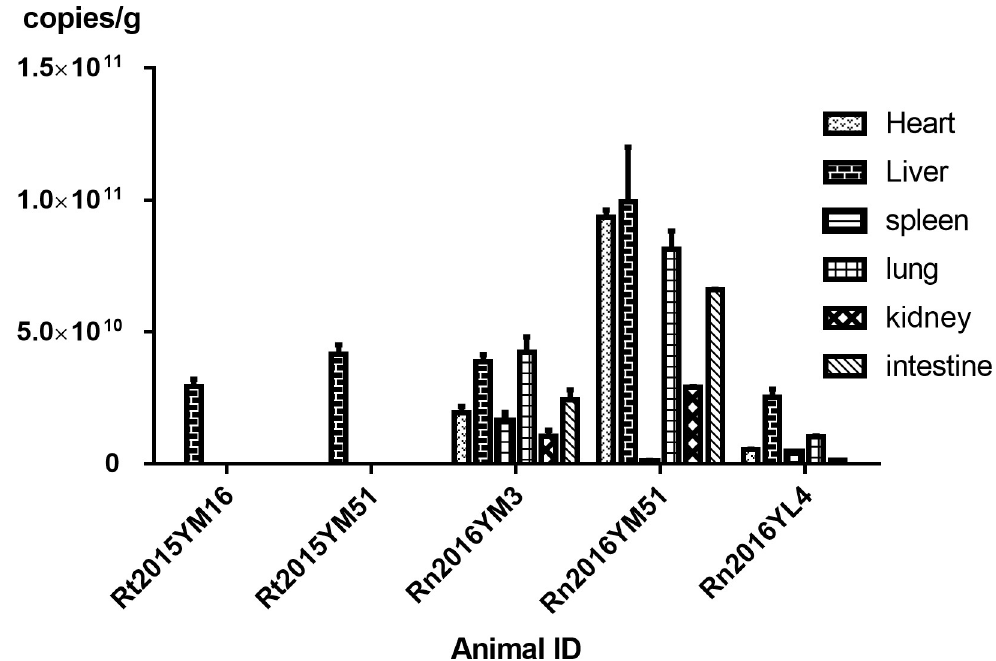
Fig 5. Real-time PCR quantification of viral genomic RNA. Five positive samples were selected and real-time PCR was used to quantify the viral RNA in the heart, liver, spleen, lung, kidney, and intestine (mean ± standard error of the mean). Units are presented in copies per